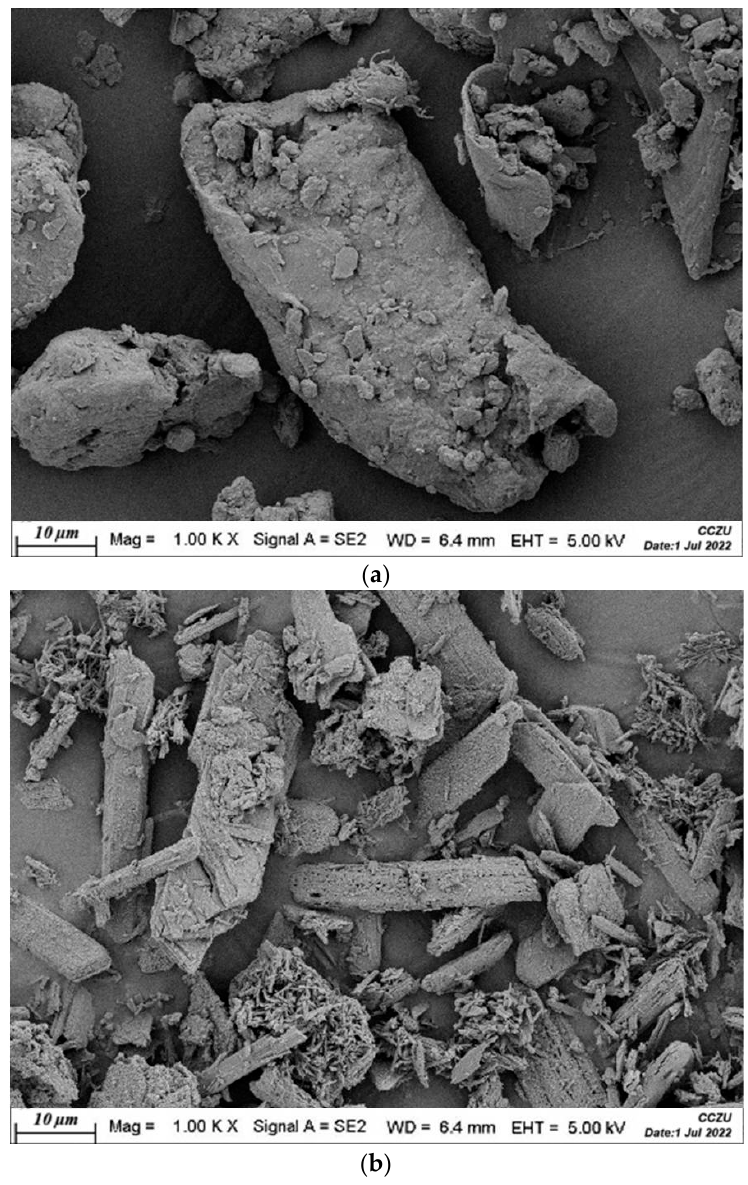
Figure 1. SEM characterization of raw LS ( a ) and UST-Sn-LS ( b ). FTIR is widely employed to obtain information on the existence of chemical bonds and functional groups [17]. The structure of the AT-Sn-WLS catalysts was further characterized by FTIR (Figure 2). It indicated that AT-Sn-WLS had a different surface compared with the untreated LS. The bond near 678 cm − 1 is associated with SnO 2 [36]. The 876 cm − 1 is assigned to β -glycosidic linkage or CO 32 − . The wide band 1141 cm − 1 is associated with the stretch vibration of C-O and S=O [46]. 1446 cm − 1 is related to the N-H stretching of chitin and C-O bending. The peak near 1648 is ascribed to amide I bonds (two types of hydrogen bonds in a CO group with the NH group of the adjacent chain and the OH group of the interchain). The peaks at around 3268 and 2934 cm − 1 are assigned to N-H and -CH in chitin, and were observed to be substantially weakened because of the removal of chitin after the preparation of AT-Sn-WLS. The bond near 3443 cm − 1 was associated with the stretching vibration of -OH [17,22].